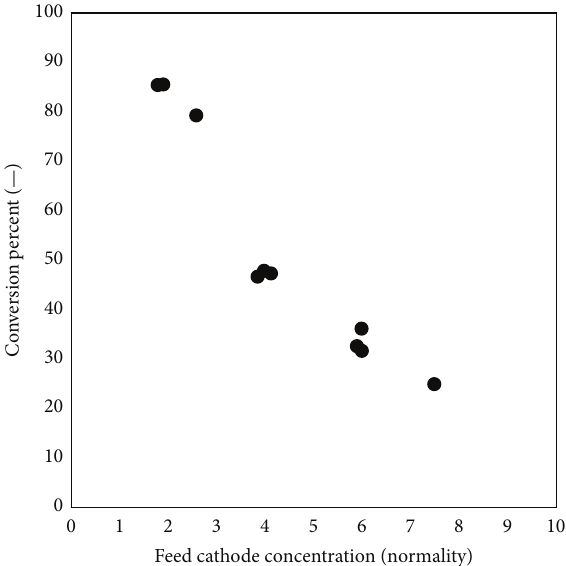
Figure 7: Conversion percent (—) versus feed cathode concentra- tion